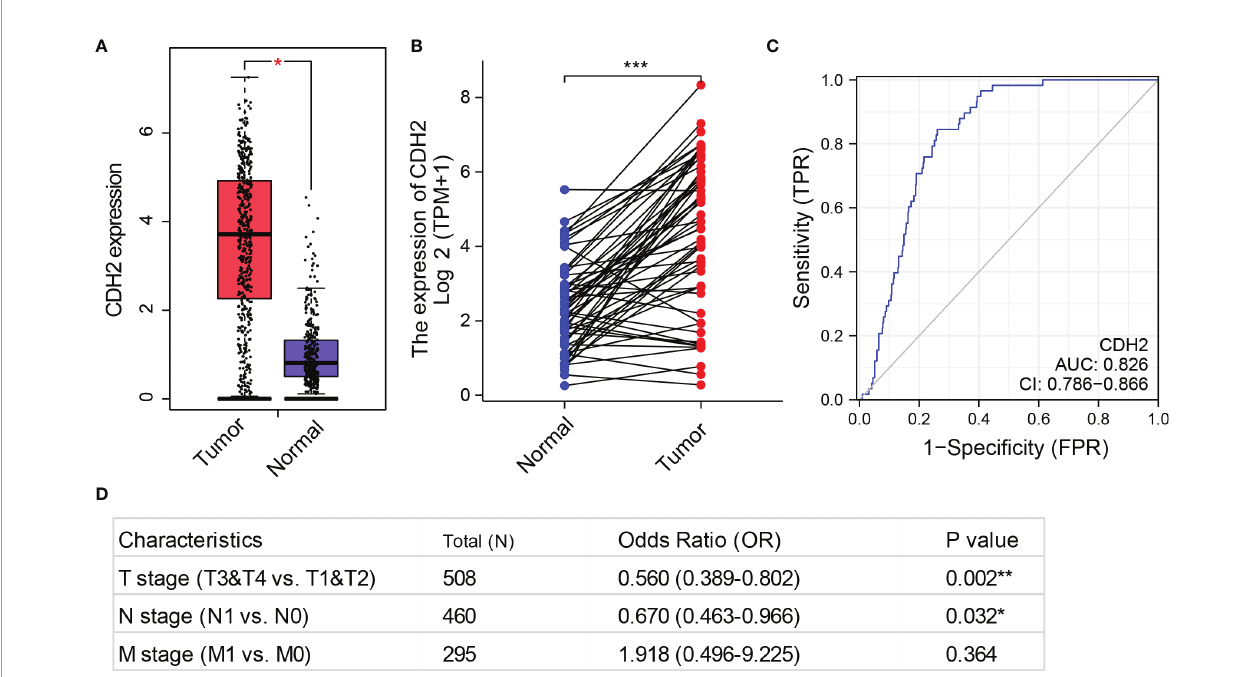
FIGURE 1 | CDH2 is overexpressed in THCA. (A) The mRNA levels of CDH2 in TCGA tumor tissues (n=512) and matched normal tissues (normal tissues in TCGA + GTEx normal tissues, n=337) were generated by GEPIA database. (B) CDH2 expression in 58 paired tissues (normal and tumor tissues) in THCA. (C) ROC curves to predict tumor and normal outcomes in THCA. (D) The associations of CDH2 mRNA expression with the stages T, N and M using univariate COX regression analysis of the TCGA dataset. *P < 0.05; **P < 0.01; ***P <